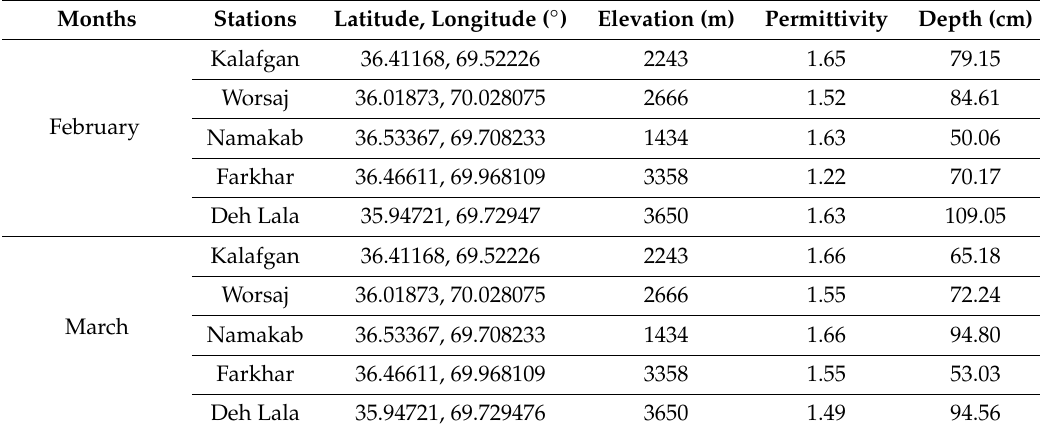
Table 3. Estimated snow properties at five target station in 2019 (see Figure